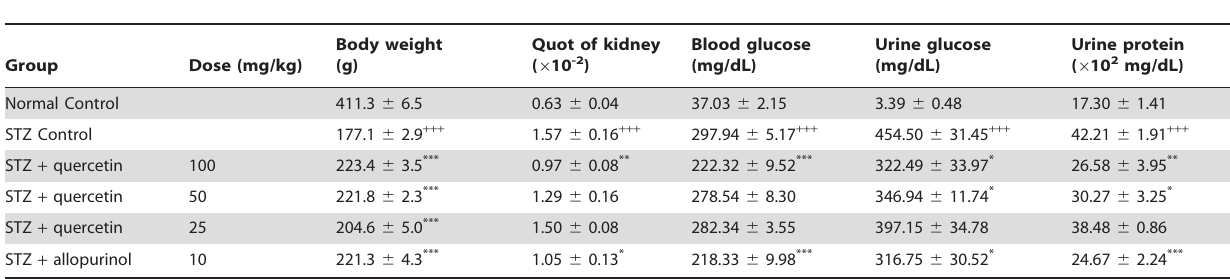
Table 2. Quercetin and allopurinol restore basic characteristics of streptozotocin (STZ)-treated rats.